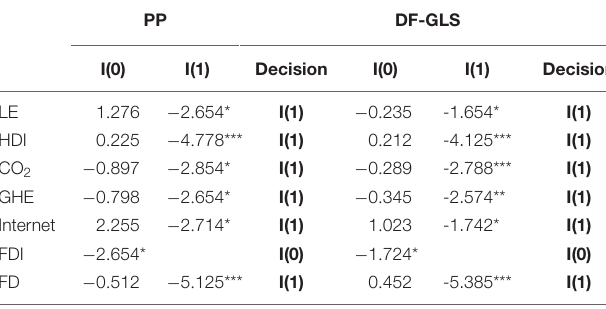
TABLE 2 | Unit root testing.